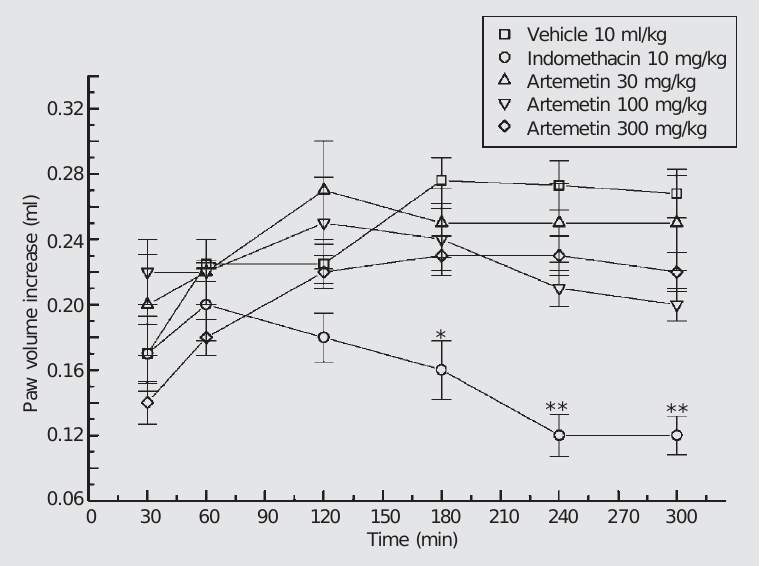
Figure 2. Effect of the artemetin fraction from Cordia curassavica ( po ) on carrageenin- induced paw edema in mice. Data are reported as means ± SEM for 6 mice in each group. *P<0.01 and **P<0.001 compared to vehicle (Duncan test).